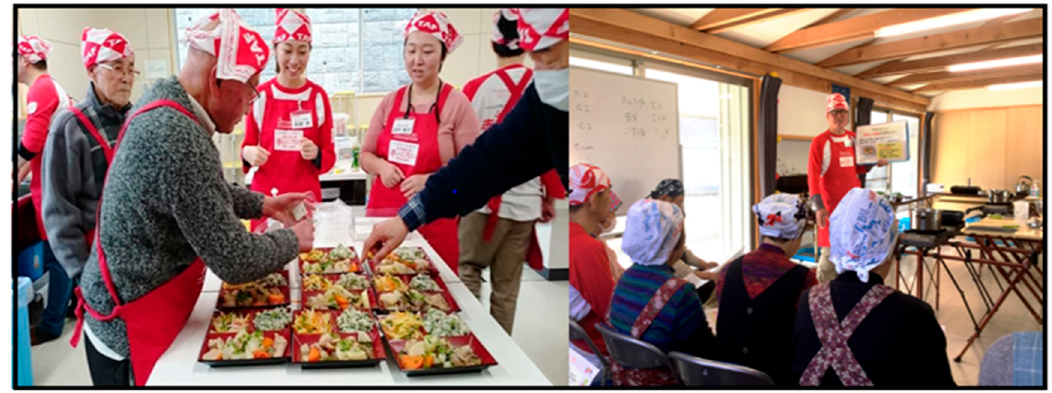
Figure 2. Cooking class: (Left) Participants’ cooking activity. (Right) Lecture using Kamishibai. (photos by authors) .